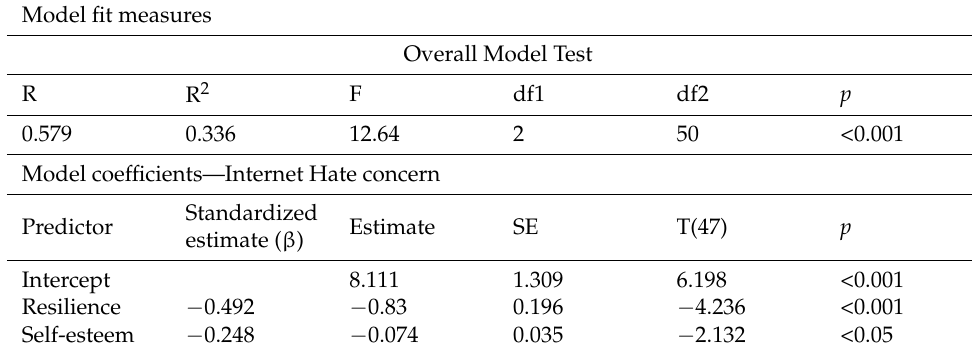
Table A2. Regression model on Internet hate concern in public figures ( n = 53).